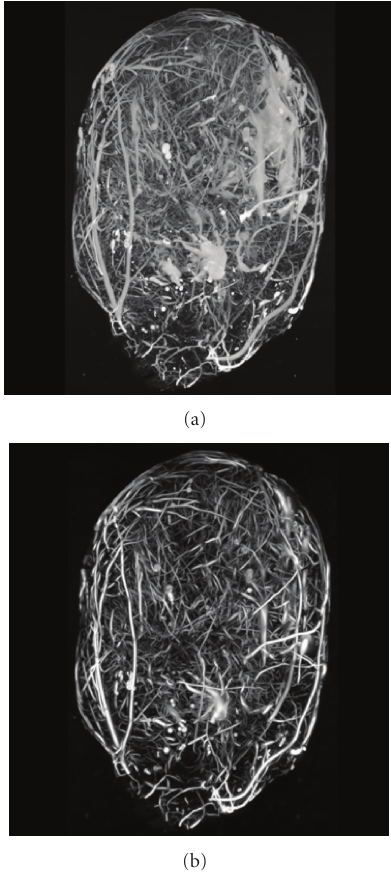
Figure 13: Histological image of cerebellar climbing fibers. (a) Input image; (b) Processed image (Image data courtesy from Professor Giorgio